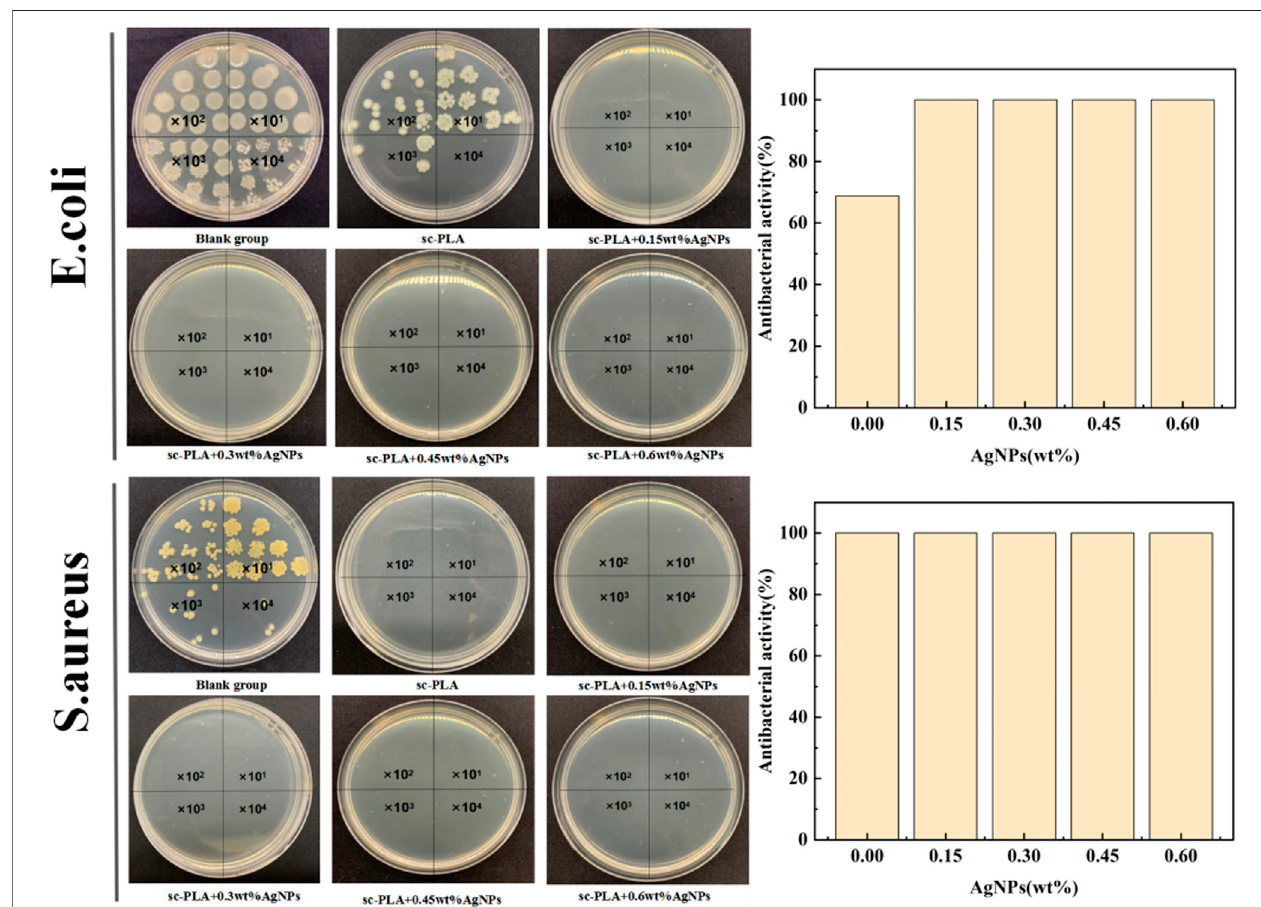
FIGURE 9 | Antibacterial activity of sc-PLA electrospun membranes containing AgNPs against E. coli and S. aureus .